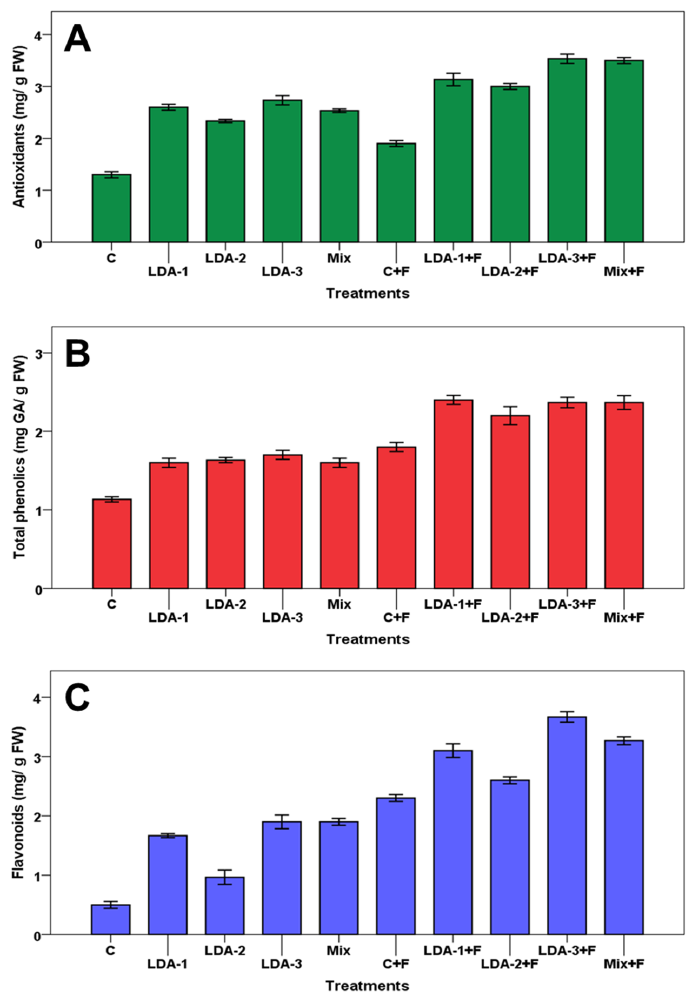
Figure 6. Effect of B. subtilis strains (LDA-1, LDA-2, and LDA-3) on antioxidants ( A ), phenolic content ( B ), and flavonoids ( C ) of cotton seedlings infested by F. solani ICADL1. C = control, F = F. solani ICADL1. The data are presented as means of three replicates, ± standard error (SE).